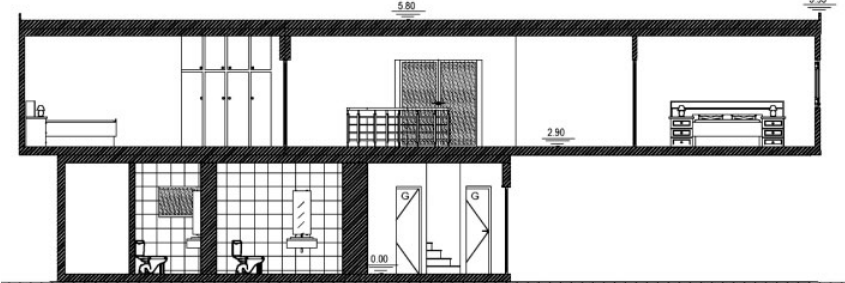
Fig. 11. Single family house: Section